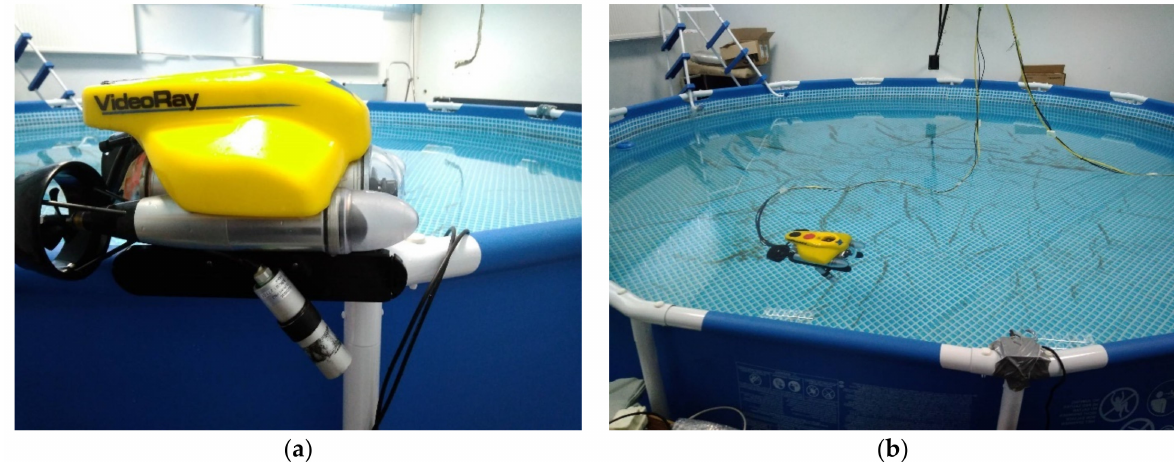
Figure 13. ( a ) VideoRay Pro 4 with stereo vision cameras; ( b ) swimming pool tests. The vehicle was marked with a red circle. Through the segmentation based on a red colour separation, the circle was detected by the vision-based measuring system